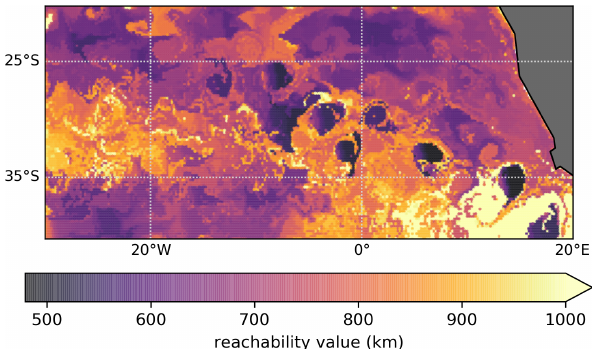
Figure 7. Reachability values at the initial time that resulted from the OPTICS algorithm being applied to the direct embedding of the trajectories. The regions with lowest values clearly correspond to Agulhas rings. The colour bar is cut off at a reachability of 1000km to show the relevant structure of the